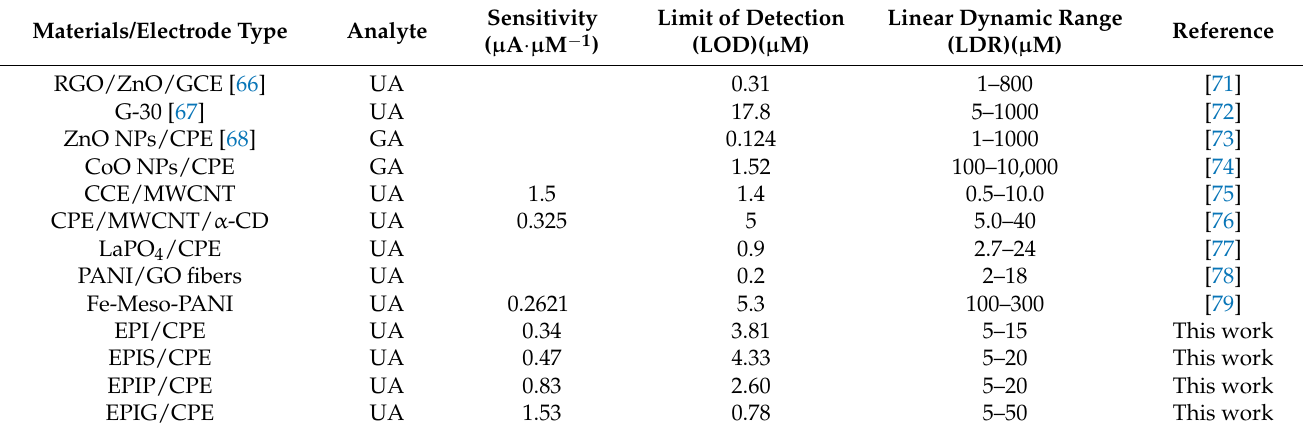
Table 1. Comparison of our electrochemical sensor with other modified electrodes using various methods reported in the literature. Materials/Electrode